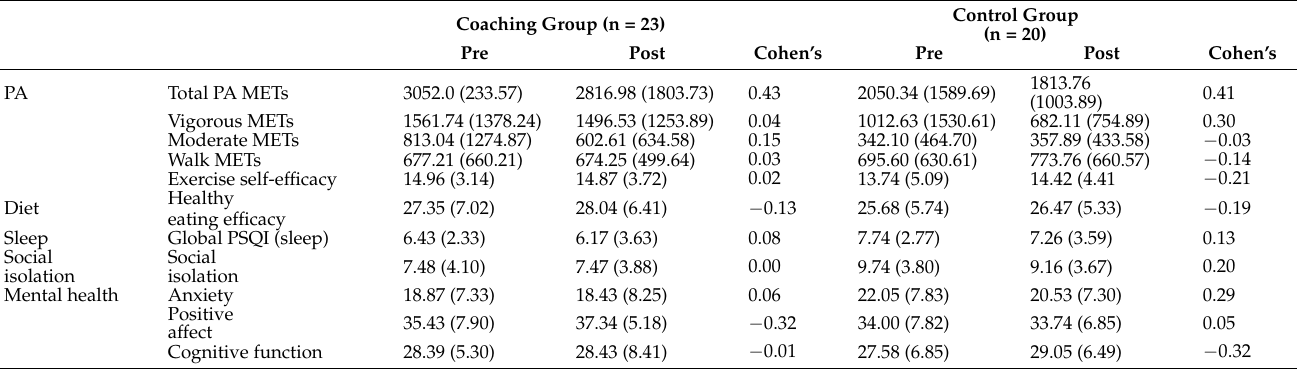
Table 2. Descriptive results of the primary and secondary constructs between coaching and control